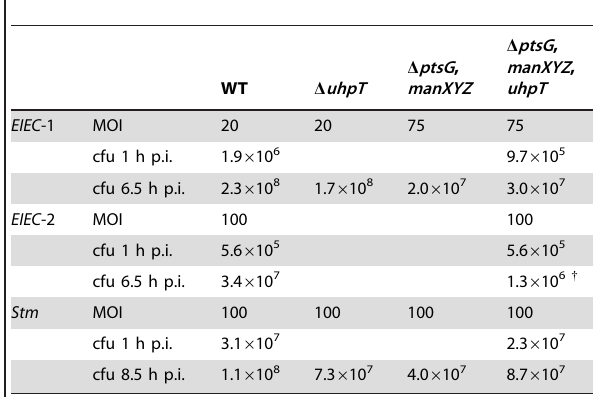
Figure 1. Glucose consumption by the host cells and the intracellular bacteria. Infection of Caco-2 cells with the three enterobacterial wild-type strains was carried out as described in Materials and Methods for 6 and 8 h, respectively, using 200 m mol of 14 C-labelled glucose per 20 ml culture medium. The columns show the amount of 14 C-label (corresponding to the consumed 14 C-glucose in m mol) incorporated into the total host cells with or without bacterial infection (hatched bars), into the separated host cells (light gray bars) and into the isolated bacteria (dark grey bars).